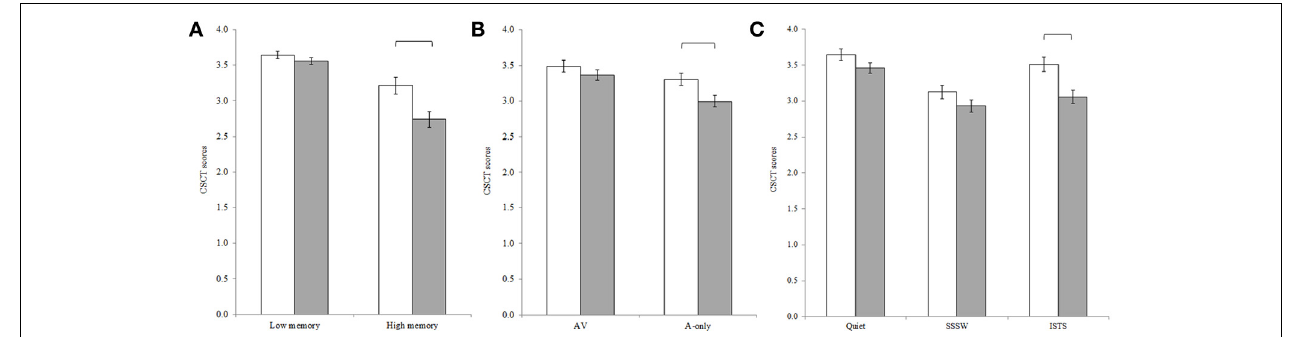
FIGURE 3 | Two-Way interactions between (A) group and memory load, (B) group and modality and, (C) group and noise, where mean CSCT raw scores for younger adults (unfilled bars) and older adults (filled bars) are shown. Error bars represent standard